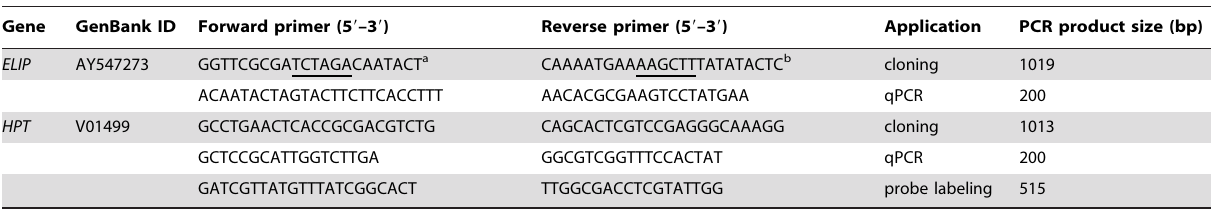
Table 1. Primers used in this